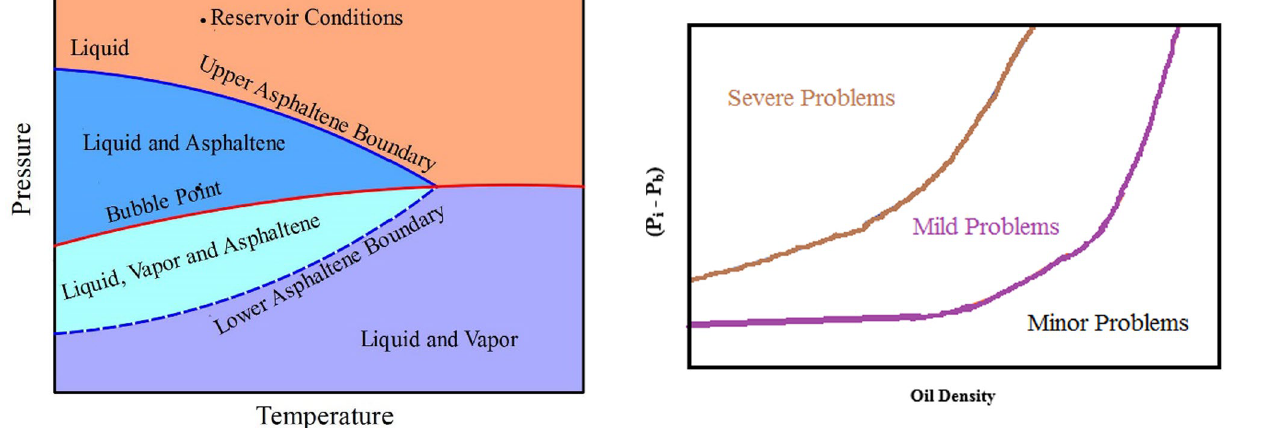
Fig. 1 Schematic of asphaltene phase envelope (Akbarzadeh et al. 2007)